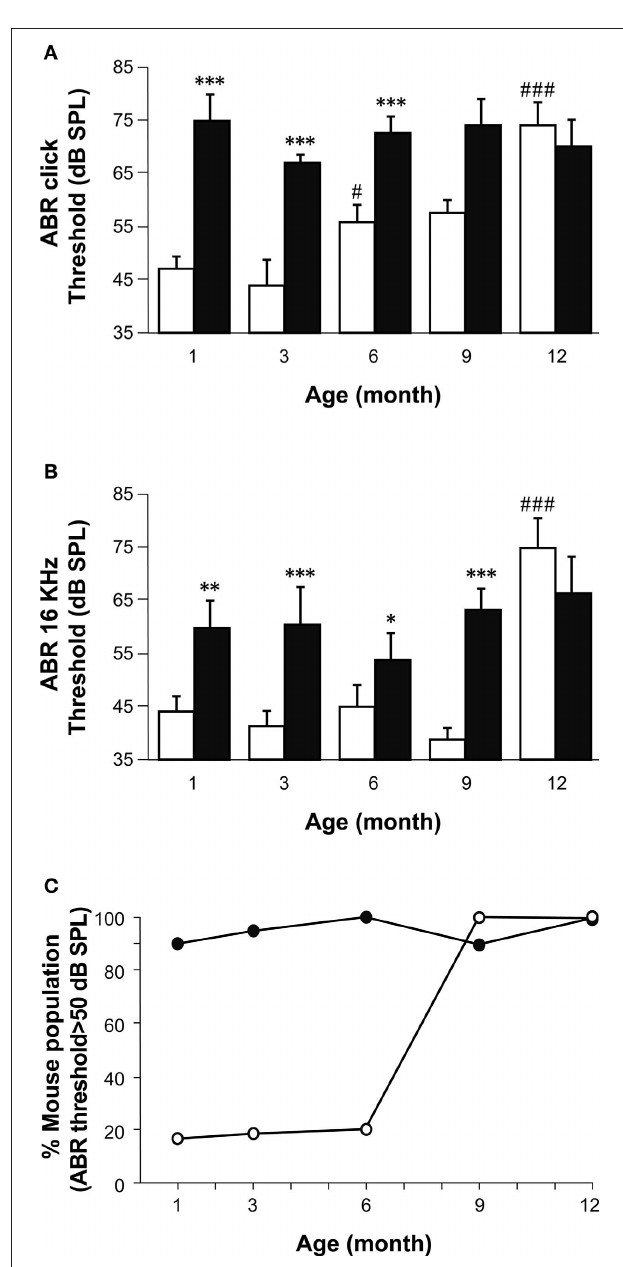
Figure 2 | A comparison of age-related hearing loss in Igf1 + / + and Igf1 − / − mice. (A) ABR thresholds in response to click stimulus in Igf1 + / + (open bars) and Igf1 − / − mice (closed bars) at different ages (1, 3, 6, 9 and 12 months). Wild type mice show an age-related increase in ABR thresholds, whereas the null mutant mice were deaf from the youngest age studied. (B) ABR responses to a 16 kHz stimuli were obtained at the same ages and showed a similar trait. (C) Percentage of individuals for each genotype showing ABR thresholds above normal hearing ( ≥ 50 dB SPL) at each of the ages studied. Wild type and null mice are represented as open and closed circles, respectively. Statistical analysis was performed with ANOVA and post hoc Bonferroni and Dunnet tests. Data are presented as the mean ± s.e.m; *indicates comparison between genotypes *** P < 0.001, ** P < 0.01 and * P < 0.05; # indicates comparison between consecutive ages ### P < 0.001. The number ( n ) of mice studied were 15, 13, 9, 8 and 7 wild type mice of 1, 3, 6, 9 and 12 month old, respectively; and 10, 11, 10, 6 and 5 null mice of the same